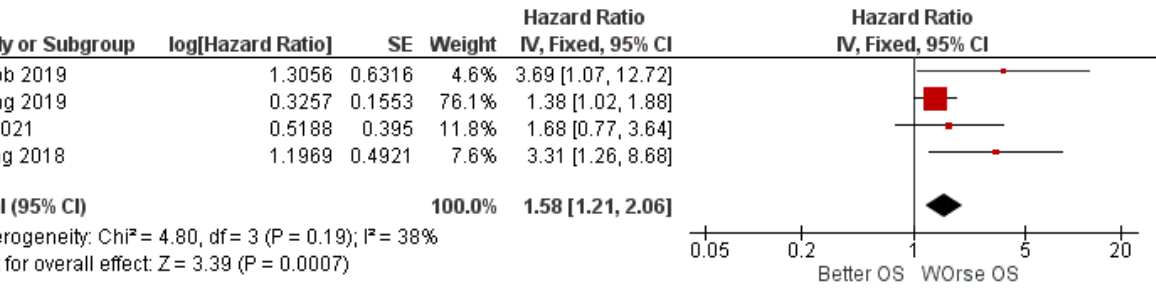
Figure 2. Forest plot of the fixed-effects model of the meta-analysis; HR = 1.58, 95% CI: [1.21, 2.06]; df = degrees of freedom; I 2 = Higgins heterogeneity index, I 2 < 50%, heterogeneity irrelevant; I 2 > 75%, significant heterogeneity; C.I. = confidence intervals; P = p value; SE = standard error. The graph for each study shows the first author and the date of publication, hazard ratio with confidence intervals, log HR standard error, and weight of each study expressed as a percentage. The final value is expressed in bold with the relative confidence intervals. The black line shows the position of the average value, and the rhombus in light black shows the measure of the average effect.